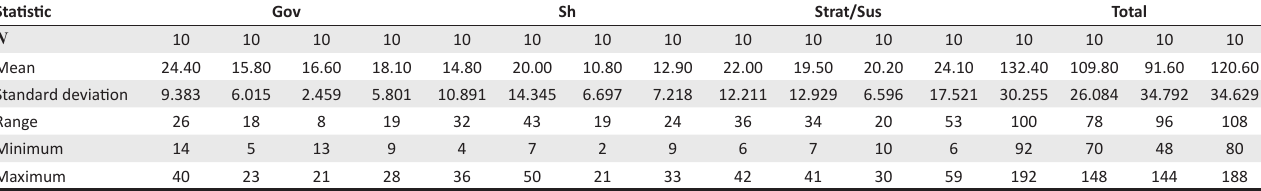
Maximum TABLE 4b: Descriptive statistical analyses of page numbers: Pick n Pay, Shoprite, Spar and Clicks. Statistic